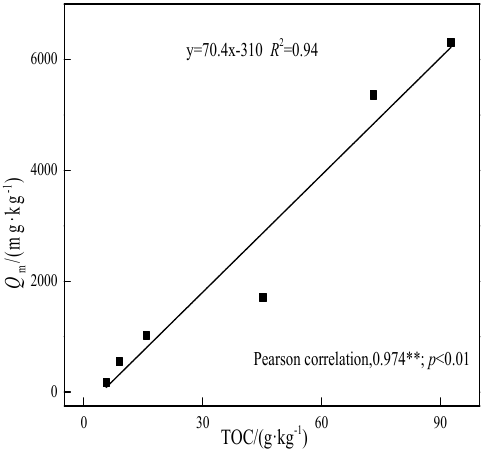
Figure 5. The relationship between the maximum adsorption capacity of cadmium on the six selected soils and TOC in the soils.